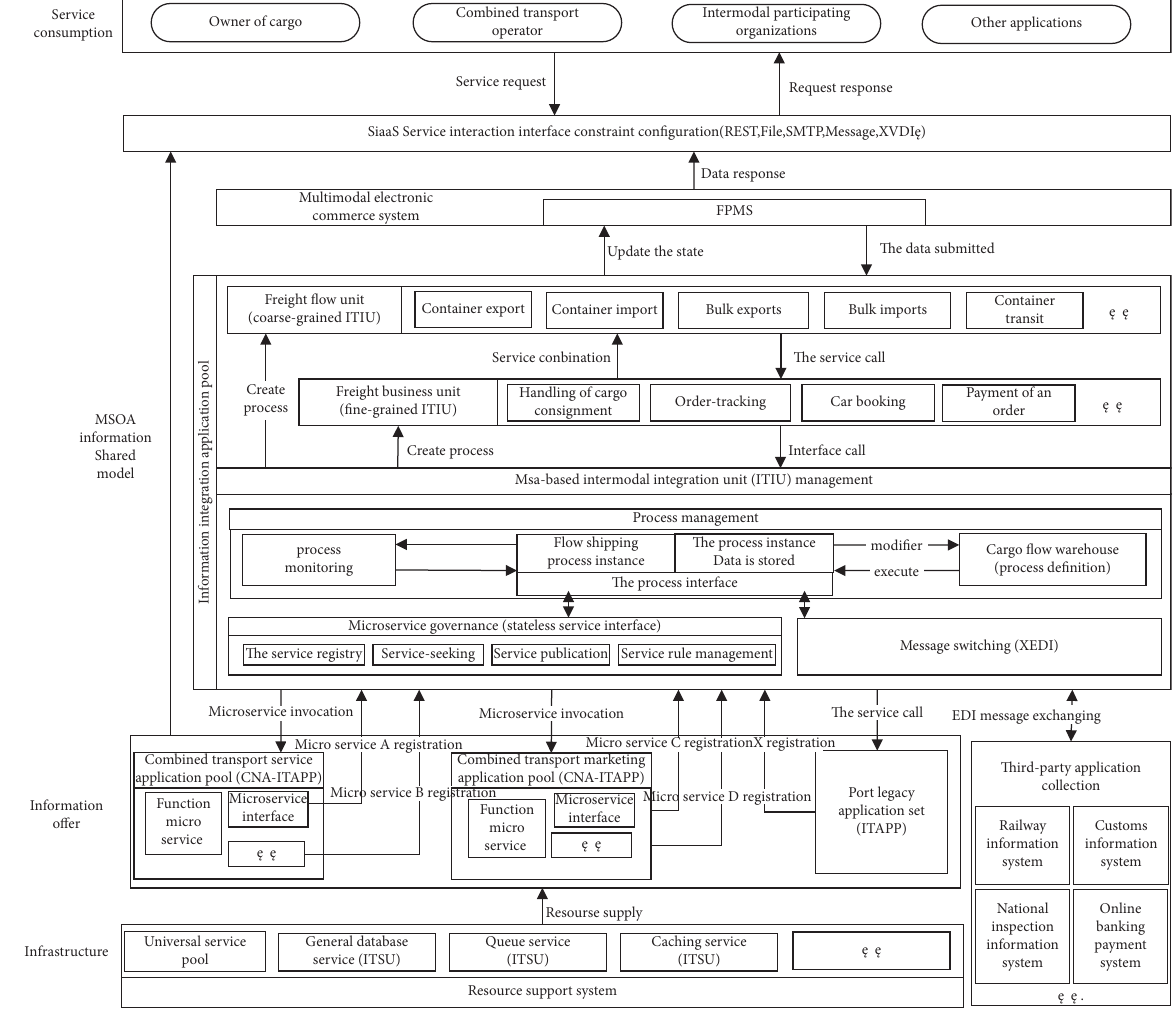
Figure 5: MSOA intermodal information sharing model